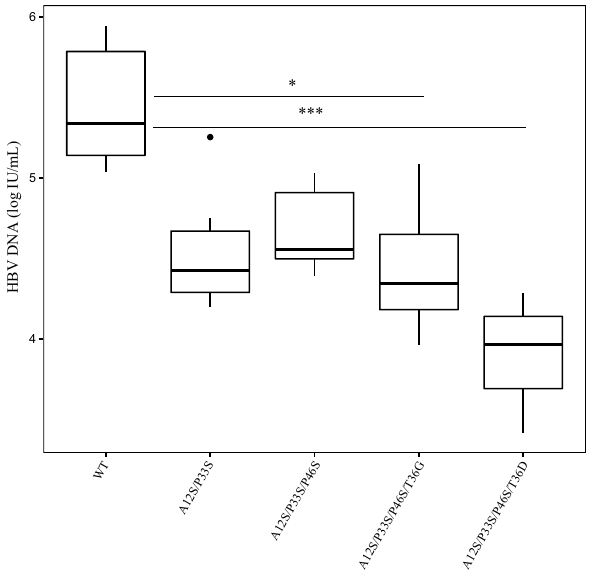
Figure 5. In vitro HBV expression in the presence of HBx mutations. The boxplot represents HBV particle release (HBV DNA in log IU/mL) in cell supernatants at 5dpt in the presence of wild type (wt) or mutated HBV monomers. The Kruskal–Wallis plus Dunn test was implemented and the p values obtained are reported as asterisks, where the number of asterisks identifies a specific p value interval (1 asterisk, < 0.05 and 3, < 0.0001). Results are the median of three experiments performed in